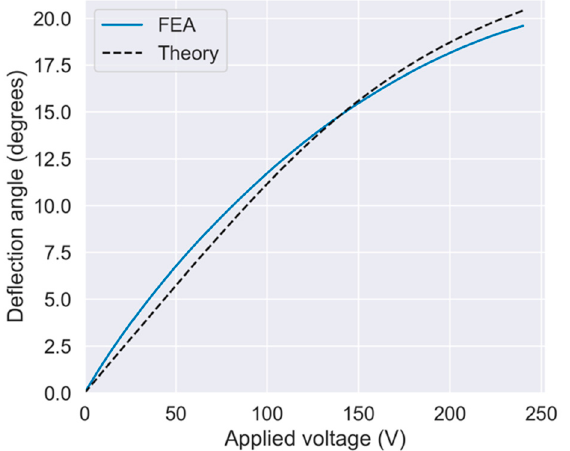
Figure 8. Relationship between applied voltage and deflection angle .